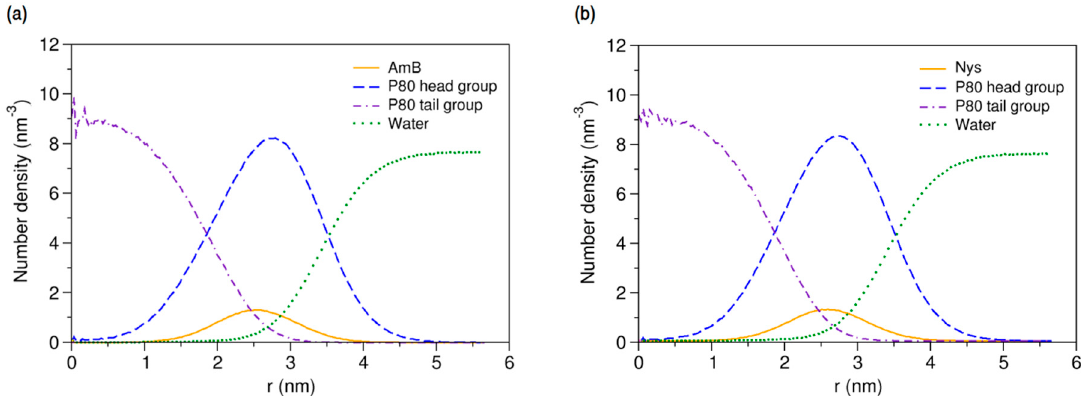
Figure 12. Radial density distributions for various molecular groups of ( a ) P80-AmB mixed micelle; and ( b ) P80-Nys mixed